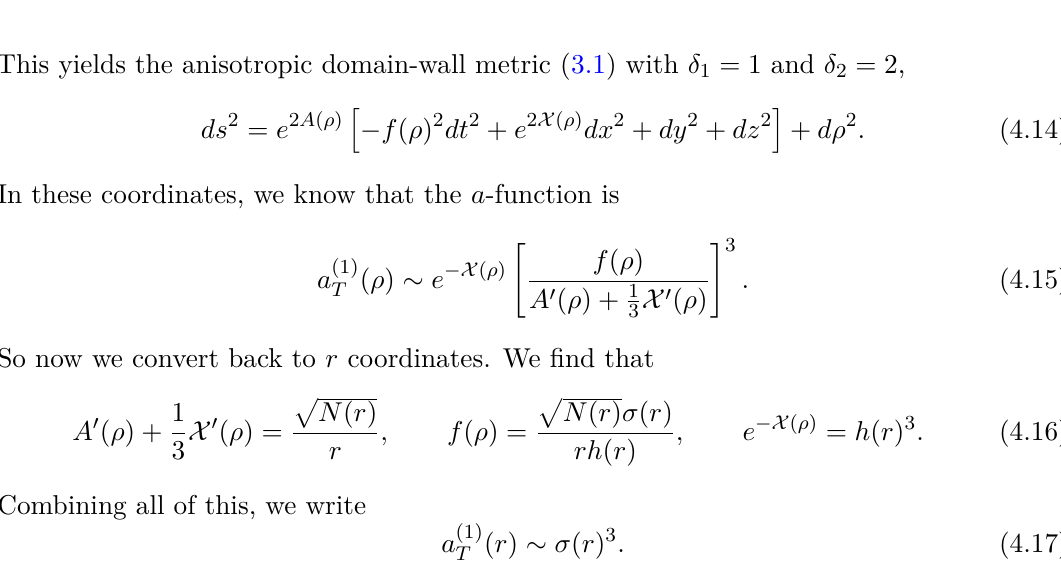
Figure 1 . Plots of the a -function (4.17) in the holographic p -wave superfluid state of [24], in terms of r (in units r h = 1 ). In the exterior (a), the function is relatively constant until r < 10 , at which point it sharply declines prior to reaching the horizon (in red). Within the interior (b), the function then exhibits fluctuations as it continues